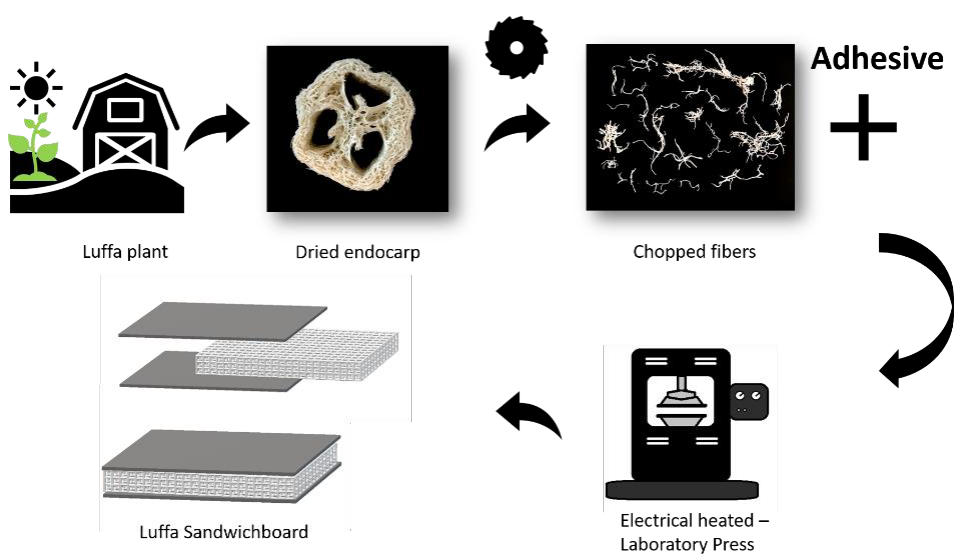
Figure 1. Schematic of the Luffa sandwich panel production. In order to obtain a homogeneous and fine fiber structure in the panel core, the Luffa fruits were shredded in a knife shredder (Güde GH 651 B, GÜDE GmbH & Co. KG, Wolpertshausen, Germany) to a fiber length between approx. 5 to 50 mm (measured with